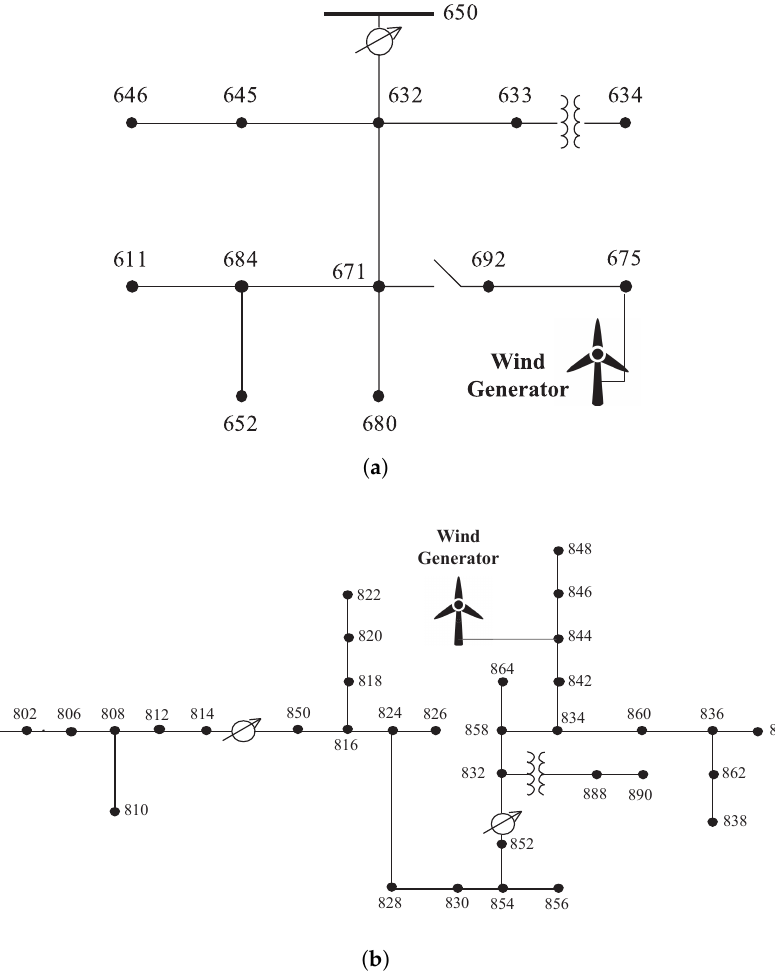
Figure 5. IEEE Node Test Feeder with local wind generator. ( a ) IEEE 13 Node Test Feeder; ( b ) IEEE 34 Node Test Feeder.